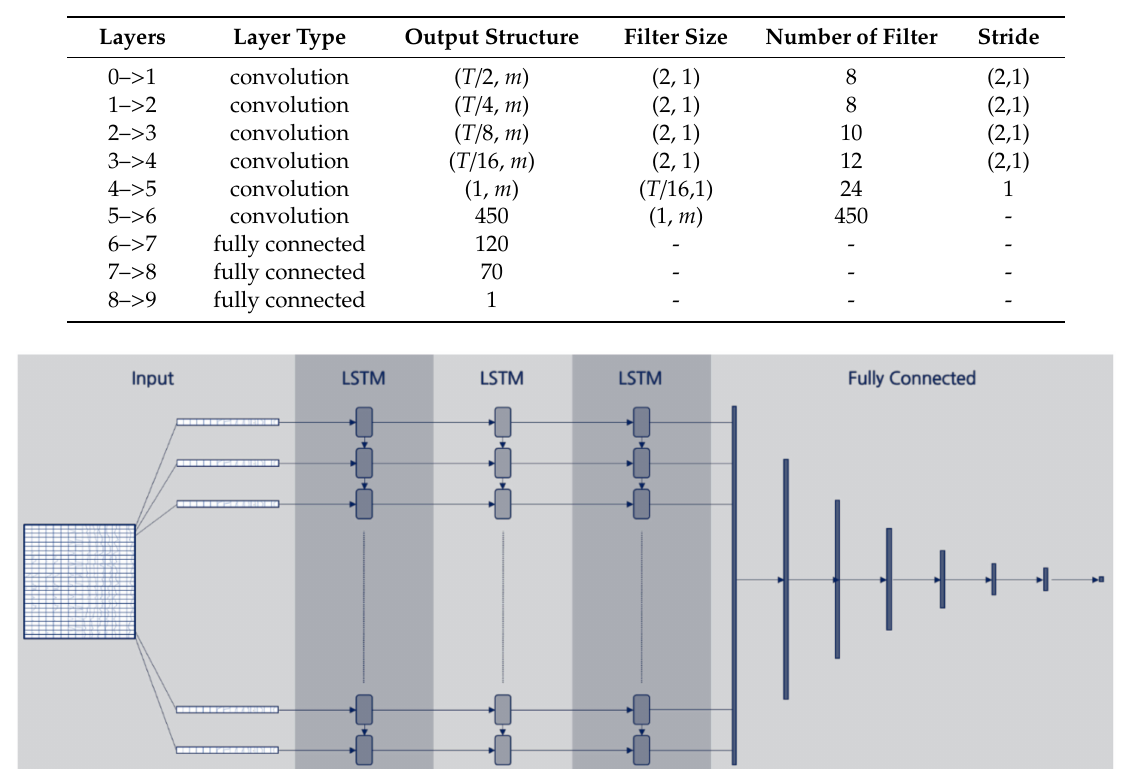
Table 6. The architecture of CNN with hourly input data.